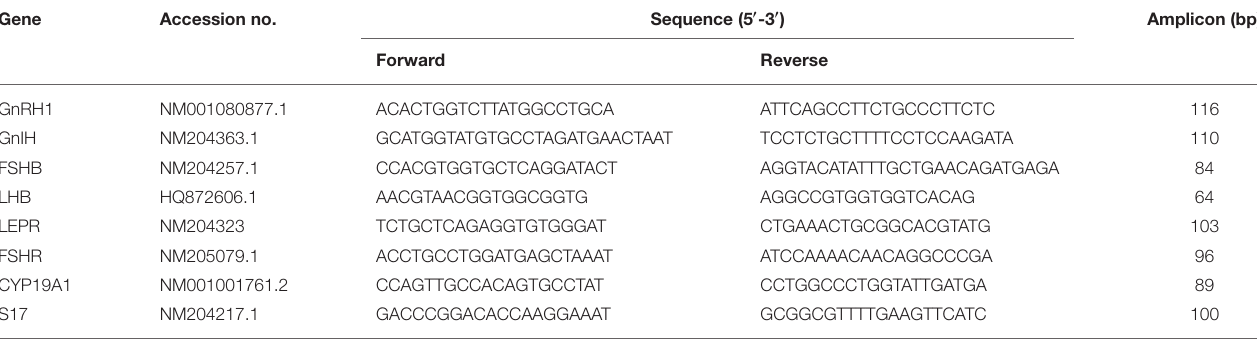
TABLE 1 | List of primers used for real-time